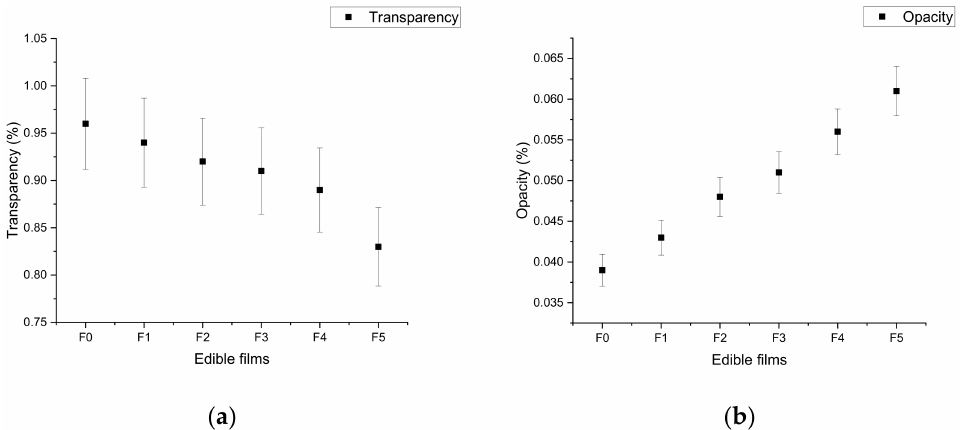
Figure 3. Effect of pomegranate peel extract on the transparency ( a )/opacity( b ) of chitosan-based edible films. F0 = control (chitosan), F1 = 0.02 g/mL PGP, F2 = 0.4 g/mL PGP, F3 = 0.6 g/mL PGP, F4 = 0.8 g/mL PGP, and F5 = 0.10 g/mL